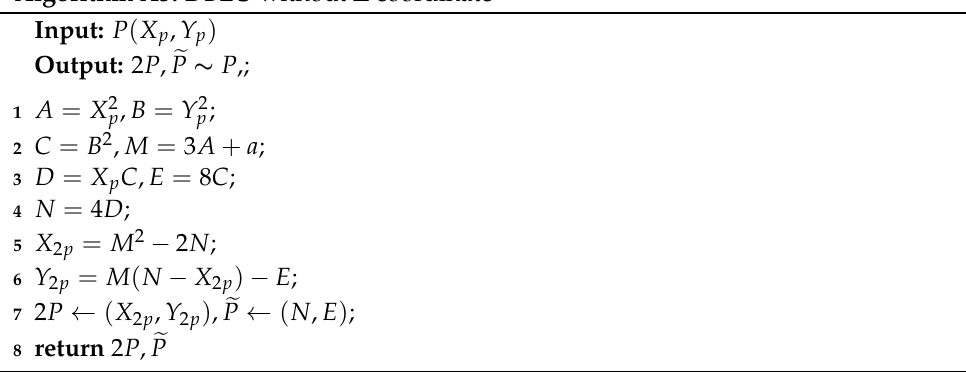
Algorithm A3: DBLU without Z